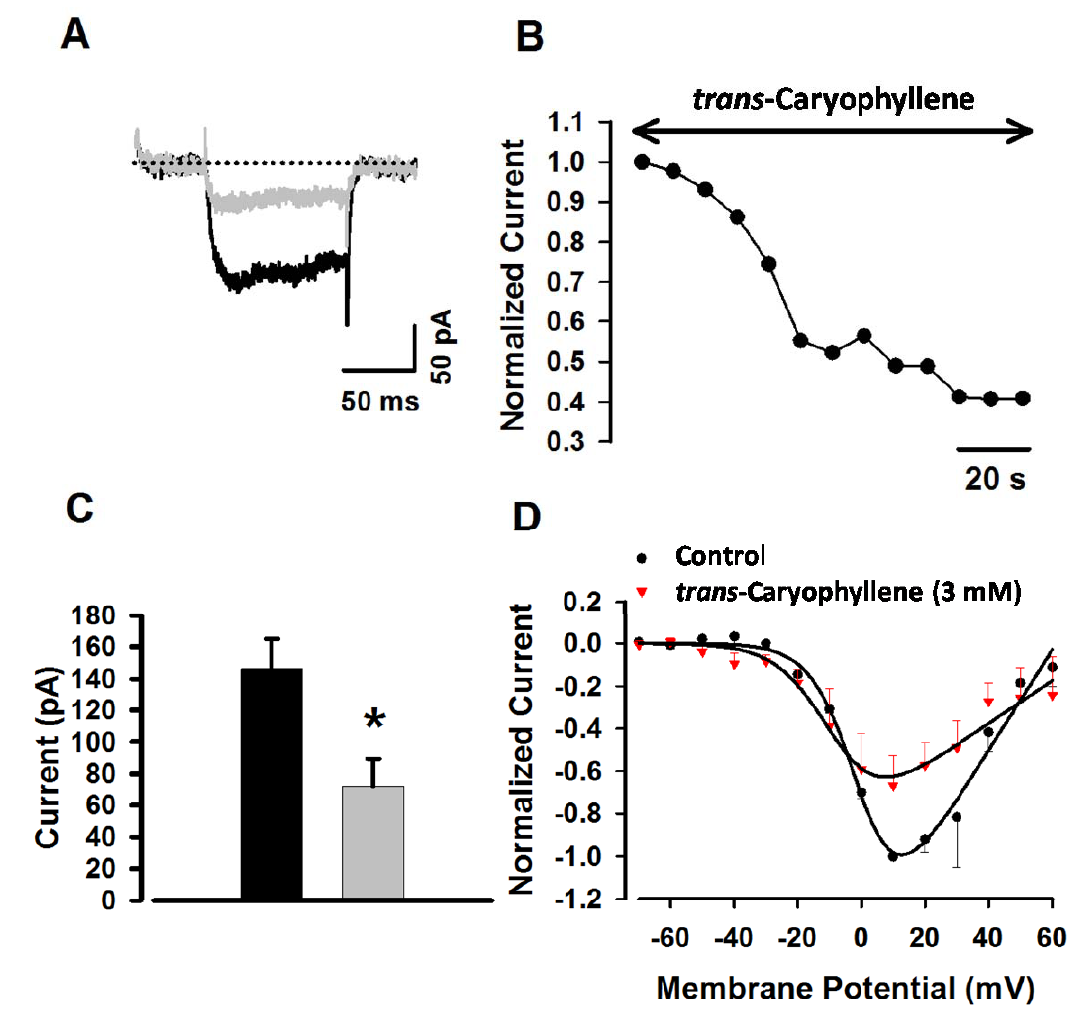
Figure 5. trans -Caryophyllene inhibited I in tracheal smooth muscle cells. ( A ) Effect of Ba evoked by a depolarizing test pulse to 10 mV from trans -caryophyllene (3 mM) on the I Ba a holding potential of − 70 mV. The dotted line denotes zero current. ( B ) Time-course of I